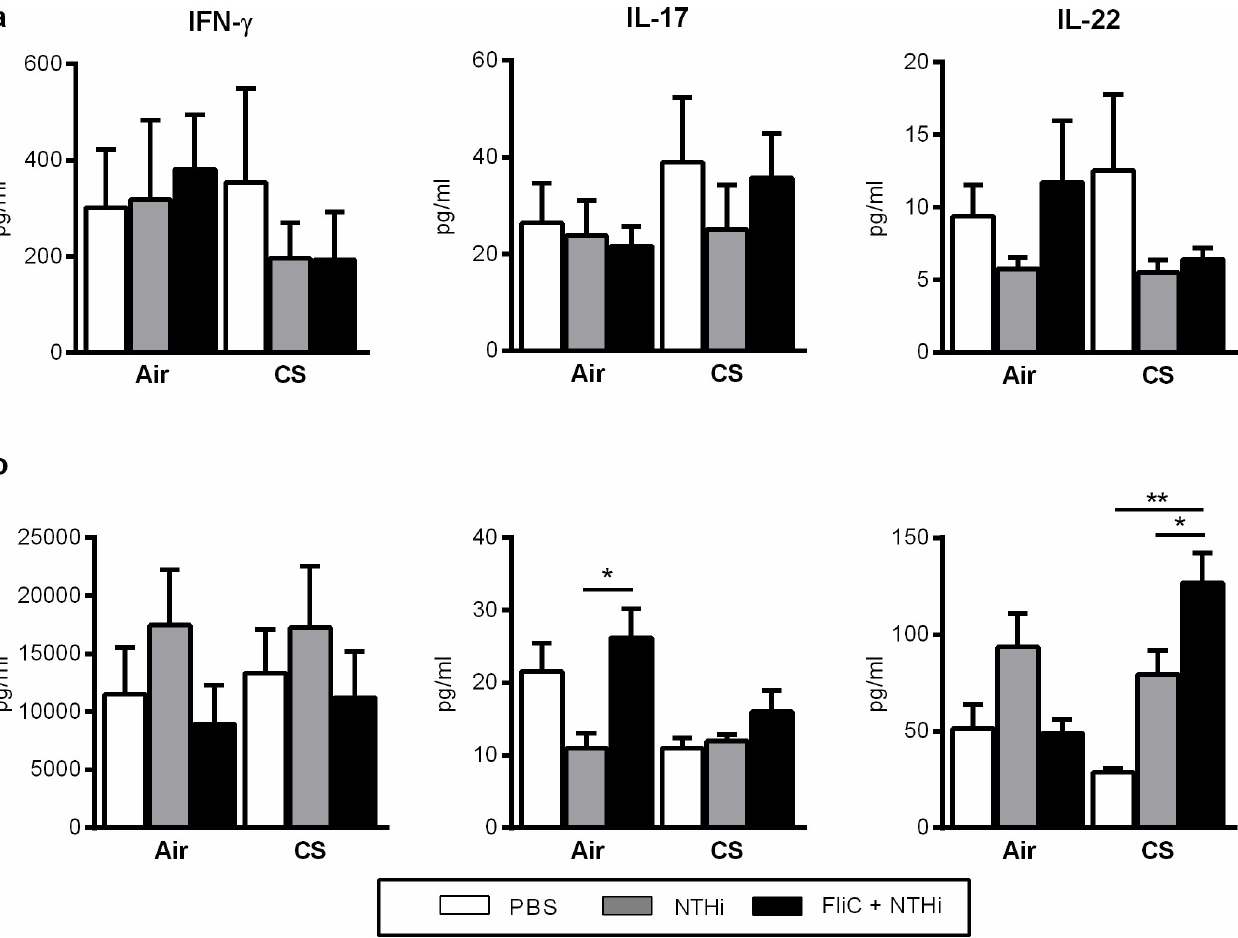
Fig 3. Flagellin modulate the production of IL-22 cytokines in splenocytes from NTHi-infected cigarette smoke-exposed mice. (a) IFN- γ , IL-17 and IL- 22 concentrations were measured in the supernatants of unstimulated spleen cells of mice infected or not with NTHi and treated or not with FliC, at 48h after infection. (b) IFN- γ , IL-17 and IL-22 concentrations were measured in the supernatants of activated spleen cells of mice infected or not with NTHi and treated or not with FliC, at 48h after infection. Spleen cells were activated by addition of heat-killed-NTHi (MOI 10) during 48 hours. Two independent experiments have been performed with at least 3–4 mice in each group. � : p < 0.05 and �� : p < 0.01.